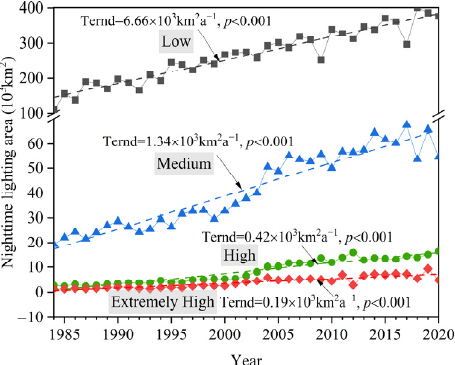
Figure 6. Long-term temporal trends in different types of nighttime lighting areas from 1984 to 2020.